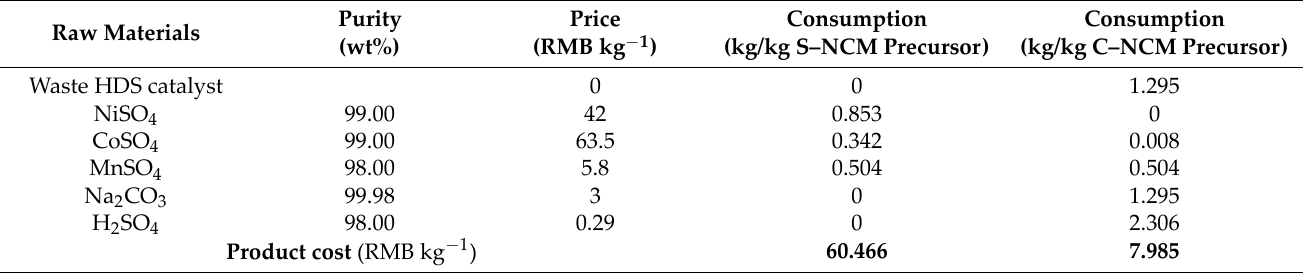
Table 2. Raw material costs for S–NCM and C–NCM